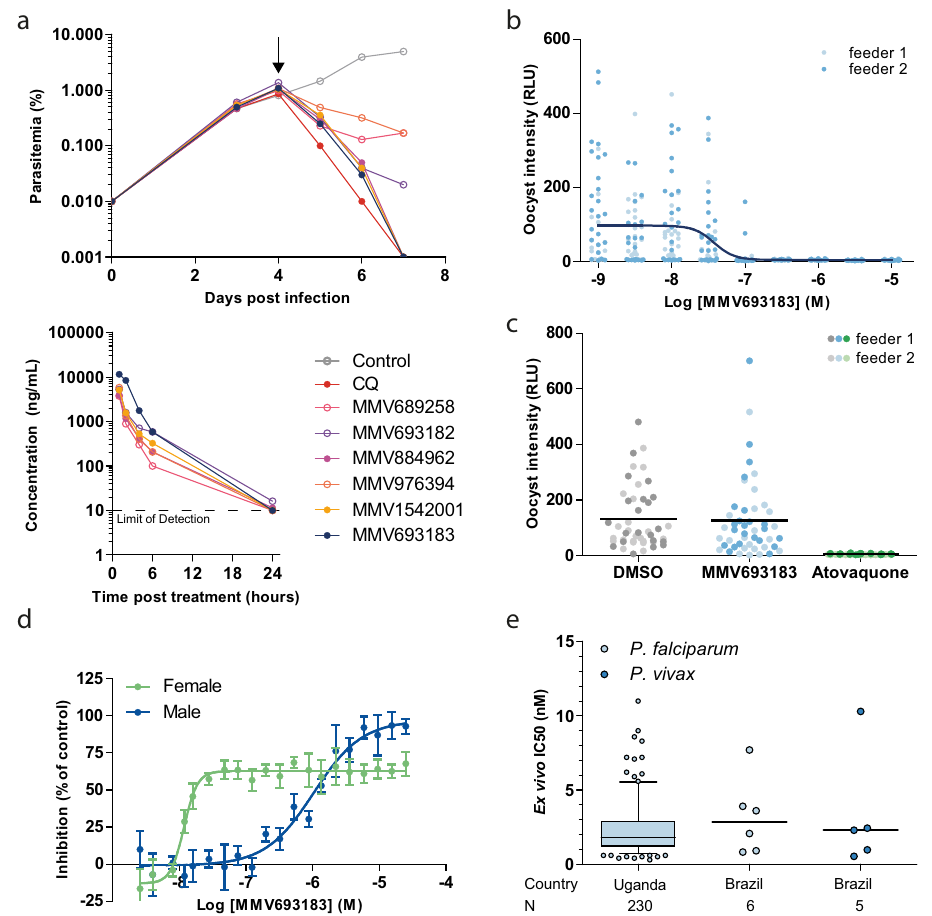
Fig. 1 Antimalarial activity of the pantothenamide MMV693183. a In vivo activity of novel pantothenamides. NSG mice were infected with P. falciparum on day 0. Mice were treated with pantothenamides by oral gavage (50 mg/kg) ( N = 2/compound) on day 4 (arrow) and parasitemia was quanti fi ed every day from day 3 onwards (top panel). The corrected concentration of pantothenamides in blood is indicated in the bottom panel. b The activity of MMV693183 on P. falciparum (NF54-HGL) stage V gametocytes treated for 24 h before mosquito feeding in a single experiment with two replicates (feeder 1, 2). Oocyst intensity was measured by luminescence eight days after the feed. c Oocyst intensities in mosquito midguts when P. falciparum (NF54-HGL) stage V gametocytes were exposed to 1 µ M MMV693183, 100 nM atovaquone, or 0.1% DMSO within the mosquito blood meal. Oocyst intensity was quanti fi ed by luminescence eight days after feeding in a single experiment with two replicates (feeder 1, 2). d Dual gamete formation assay upon treatment of female or male gametocytes with MMV693183 in four independent experiments (±SD). Typically, 150-250 ex fl agellation centers or 2000-3000 female gametes per fi eld were recorded in the negative controls. e Ex vivo activity of MMV693183 against fi eld isolates of P. falciparum from Uganda ( N = 230) in a parasite growth assay and against fi eld isolates of P. falciparum ( N = 6) and P. vivax ( N = 5) from Brazil in a schizont maturation assay. Median IC 50 values and 5-95 percentile are shown in a Box-Whisker plot for the fi eld isolates from Uganda. Minimum: 0.3 nM, maximum: 11.0 nM, box: 25-75 percentile, whiskers: 5-95 percentile. CQ, chloroquine. Source data are provided as Source Data fi